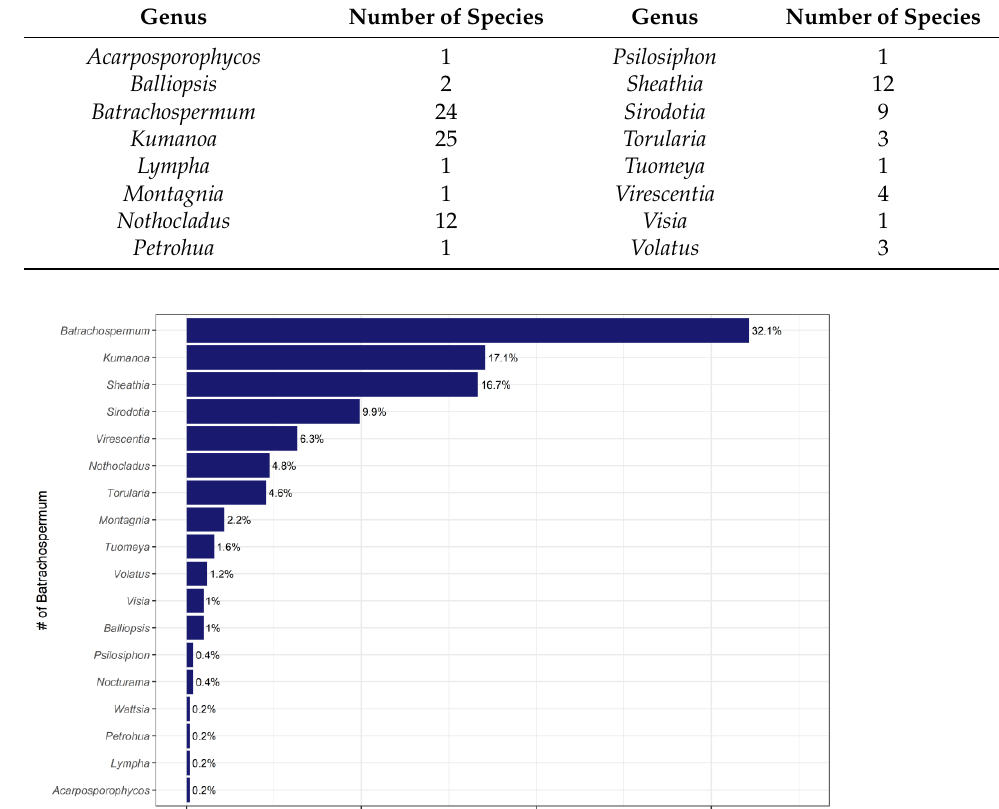
Figure 7. The proportion of sample data of each genus of Batrachospermaceae.